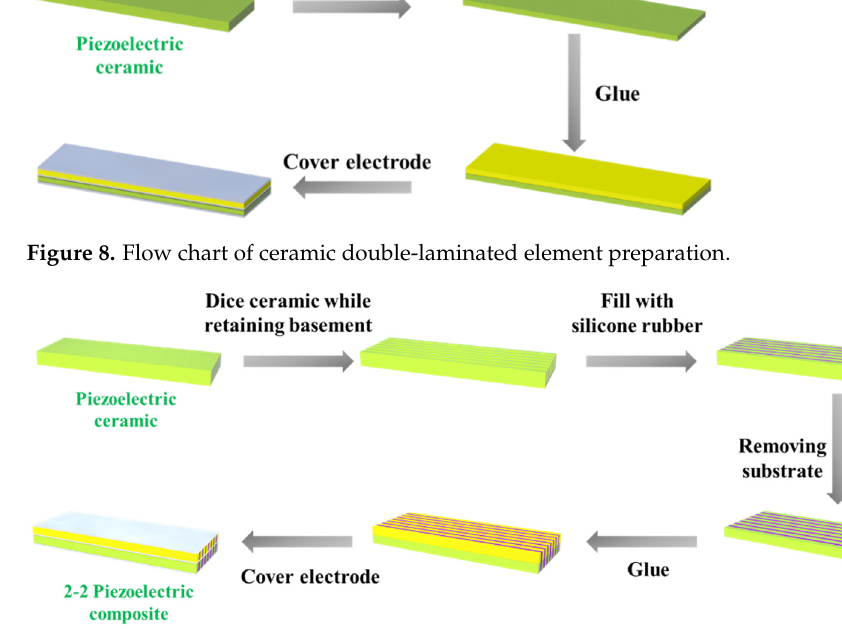
Figure 9. Flow chart of 2-2 piezoelectric composite double-laminated element preparation.